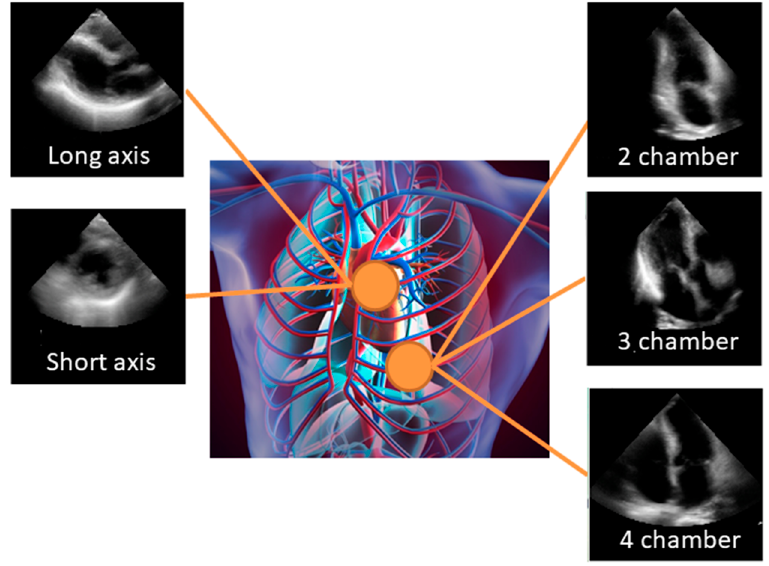
Figure 1. Standard views: The apical 2-chamber (AP2), apical 4-chamber (AP4), apical 3-chamber (AP3), parasternal long axis (PLAX), and parasternal short axis (PSAX) views were stored digitally for playback and analysis. Echocardiographic images shown here are the average of 10 consecutive images.